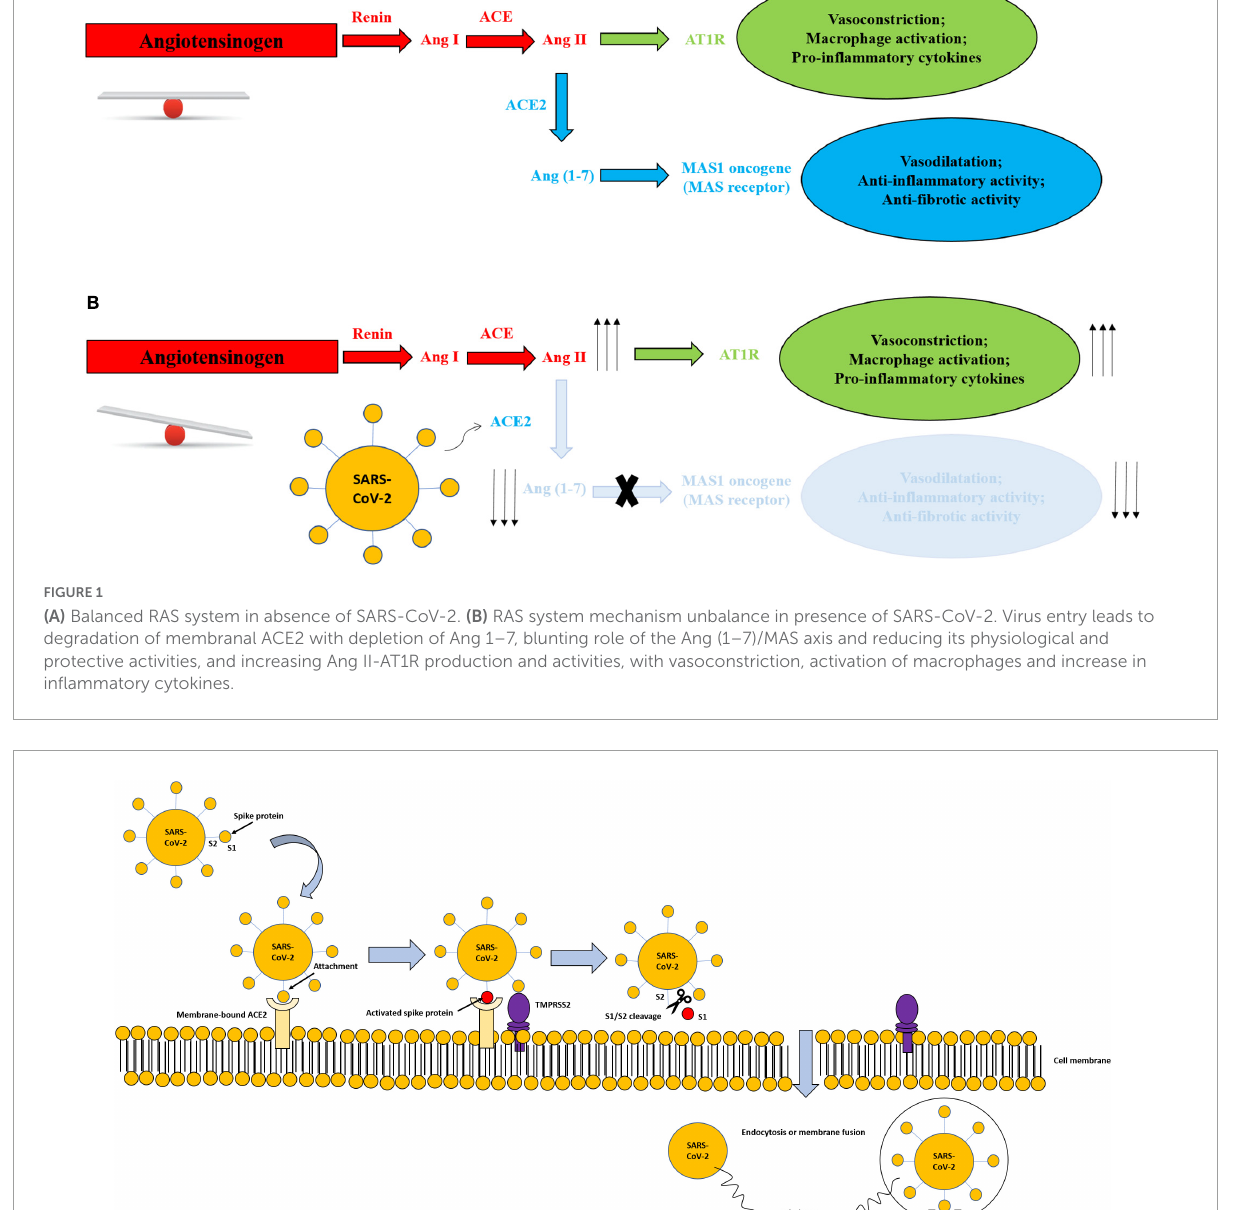
skeletal development and bone homeostasis (44). In particular, after COVID-19 entry, the decrease in ACE2 activity is associated with an upregulation of WNT pathway, inducing several pathologies, such as hypertension, heart disease, and cancer (45).